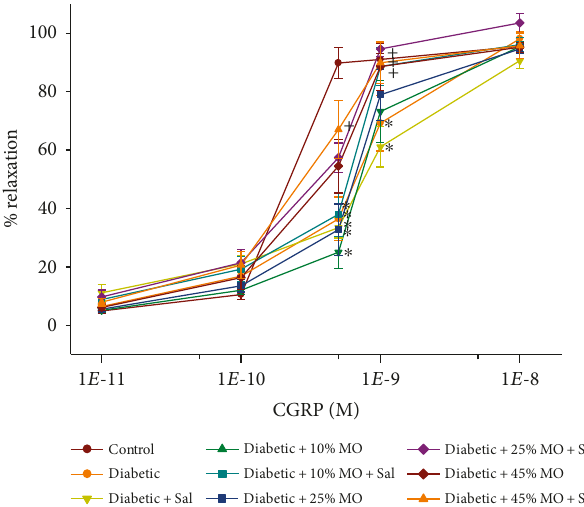
Figure 3: E ff ect of menhaden oil concentration with or without salsalate on vascular relaxation by calcitonin gene-related peptide in epineurial arterioles of the sciatic nerve in Sprague Dawley type 2 diabetic rats. Pressurized arterioles (40 mmHg and ranging from 60 to 100 μ m luminal diameters) were constricted with phenylephrine (30 – 50%), and incremental doses of calcitonin gene-related peptide were added to the bathing solution while recording steady-state vessel diameter. The number of rats in each group was the same as shown in Table 1. Data are presented as the mean of % relaxation ± SEM . ∗ P < 0 05 compared to control rats; + P < 0 05 compared to diabetic